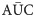
Classifying imminent feeding from other behavior with VS oscillations.A. Overview of analysis flow. Data was binned and power and coherence extracted as in Fig 1. Orange box: Eighty percent of all pre-feeding bins immediately before feeding bins and all other bins outside of feeding (not-feeding and rest) are used for model training and the other 20% are used for testing. Using the same data, the assignment of category to predictor variables is permuted and trained on 80% of the data and tested on the left out 20%. This analysis produces two receiver operator (ROC) curves representing the performance of models built from actual and permuted data. To build rare event detectors (feeding is only ~18% of the data) the adaptive synthetic sampling approach for imbalanced learning was found to be the best option (Fig 2-1A-B). To be able to compare across models it was also necessary to determine the number of samples were required to achieve stable model performance (Fig 2-1A-D). B. Average performance of differentiating pre-feeding immediately before feeding begins and bins outside of feeding (not-feeding and rest); performance distribution statistics reported as AUC mean ± 95% confidence interval and the effect size between Actual and Permuted given as Cohen’s d: Actual = 0.81±0.03; Permuted = 0.55±0.06; d = 2.68. C. Average areas under the ROC curves (AUC¯) obtained for 20 iterations of model building using models built from the pre-feeding bins immediately preceding feeding and tested on all other pre-feeding bins grouped by amount of time before feeding up to bins centered 42.5 seconds before feeding. D. Percent of pre-feeding data which overlaps with approach behavior; pre-feeding bins centered up to 12.5 seconds before feeding have at most 30% overlap with approach behavior. E-F. Normalized representative LFP features plotted through time around feeding. Features were normalized by either total power or by average coherence of the channel(s) of interest and averaged across all bins and animals around the beginning and end of feeding epochs. Shading indicates ±1 standard deviation. Black traces represent averages before and after feeding and blue traces represent averages during feeding. Dashed blue and solid black lines indicate average feature activity for either feeding bins or all other bins including those outside of these plots. E. Core left core right high gamma coherence increases during feeding. F. Shell left high gamma power decreases during feeding. Although both E and F exhibit a mean shift; a decrease in feature variance around feeding was also found (Fig 2–2).